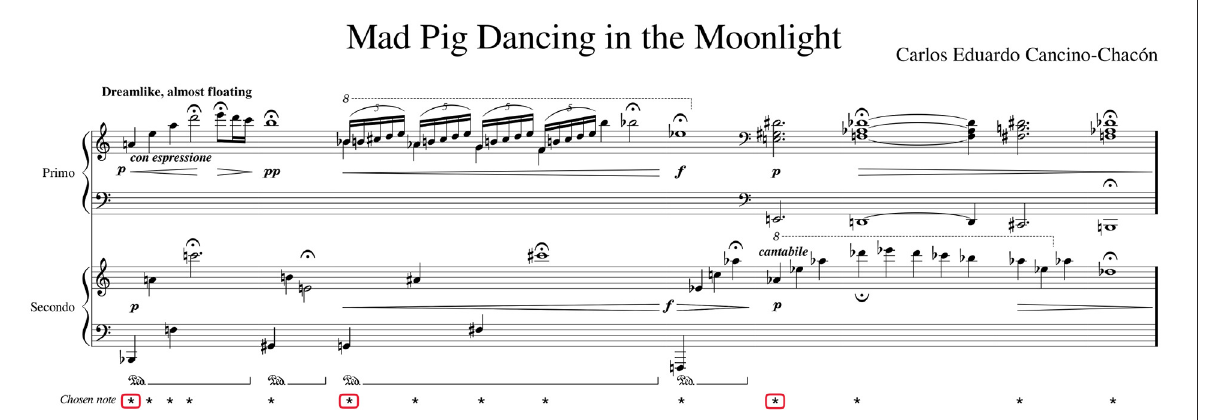
FIGURE1 Piano duo excerpt from Bishop et al. (2019a) that was used in the current investigation. The figure displays the notes and chords, highlighted with *, upon which the analysis of interpersonal synchronization was based, as well as the initial note, highlighted with red rectangle, of the three musical phrases comprising this section. The figure is © Bishop et al. (2019a), licensed CC-BY.